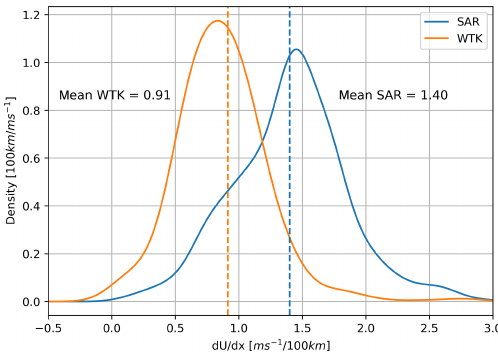
Figure 13. Density plot of wind speed gradients from SAR and WTK. Dashed lines indicate the mean